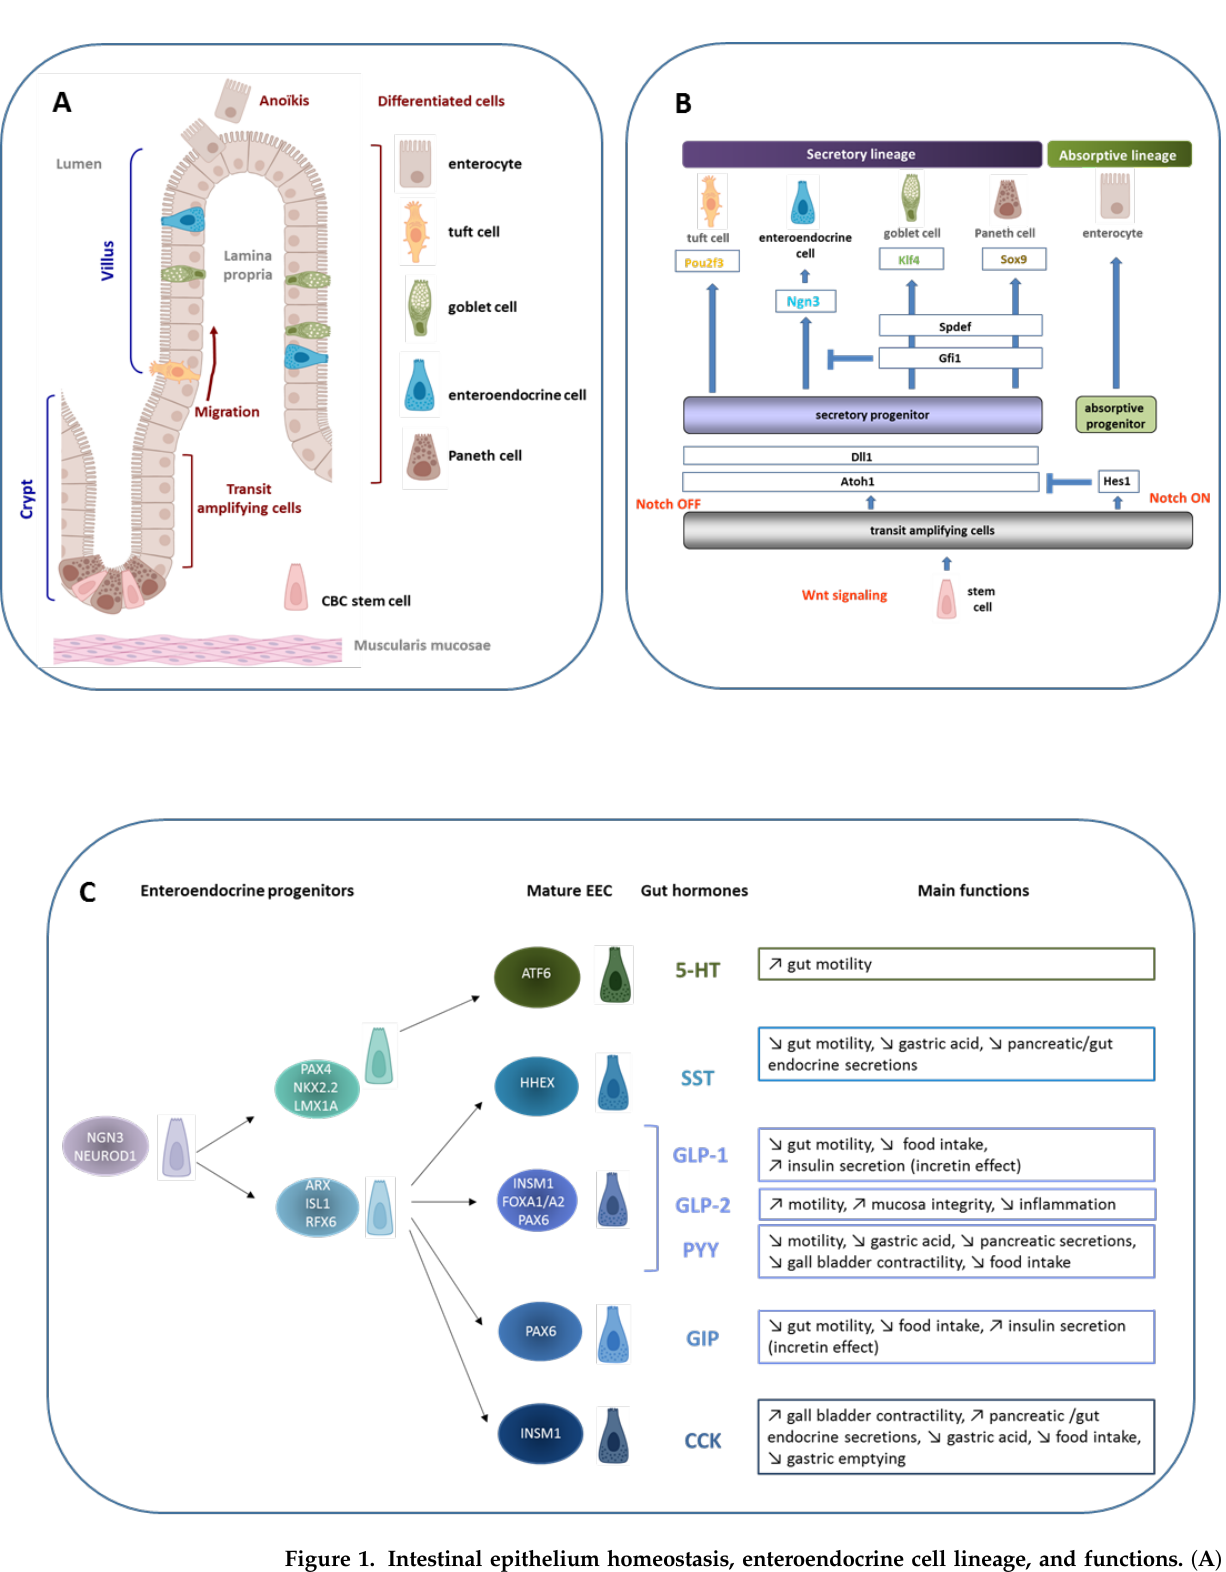
Figure 1. Intestinal epithelium homeostasis, enteroendocrine cell lineage, and functions. ( A ) The intestinal epithelium is composed of a single layer of cells lying on a mesenchymal tissue, the lamina propria, which contains connective tissue and vascular structure. In the small intestine, the epithelium is organized into villi that project in the intestinal lumen, with crypts which invaginate in the mucosa. This structural unit rests on a thin layer of smooth muscle, the muscularis mucosa. The intestinal